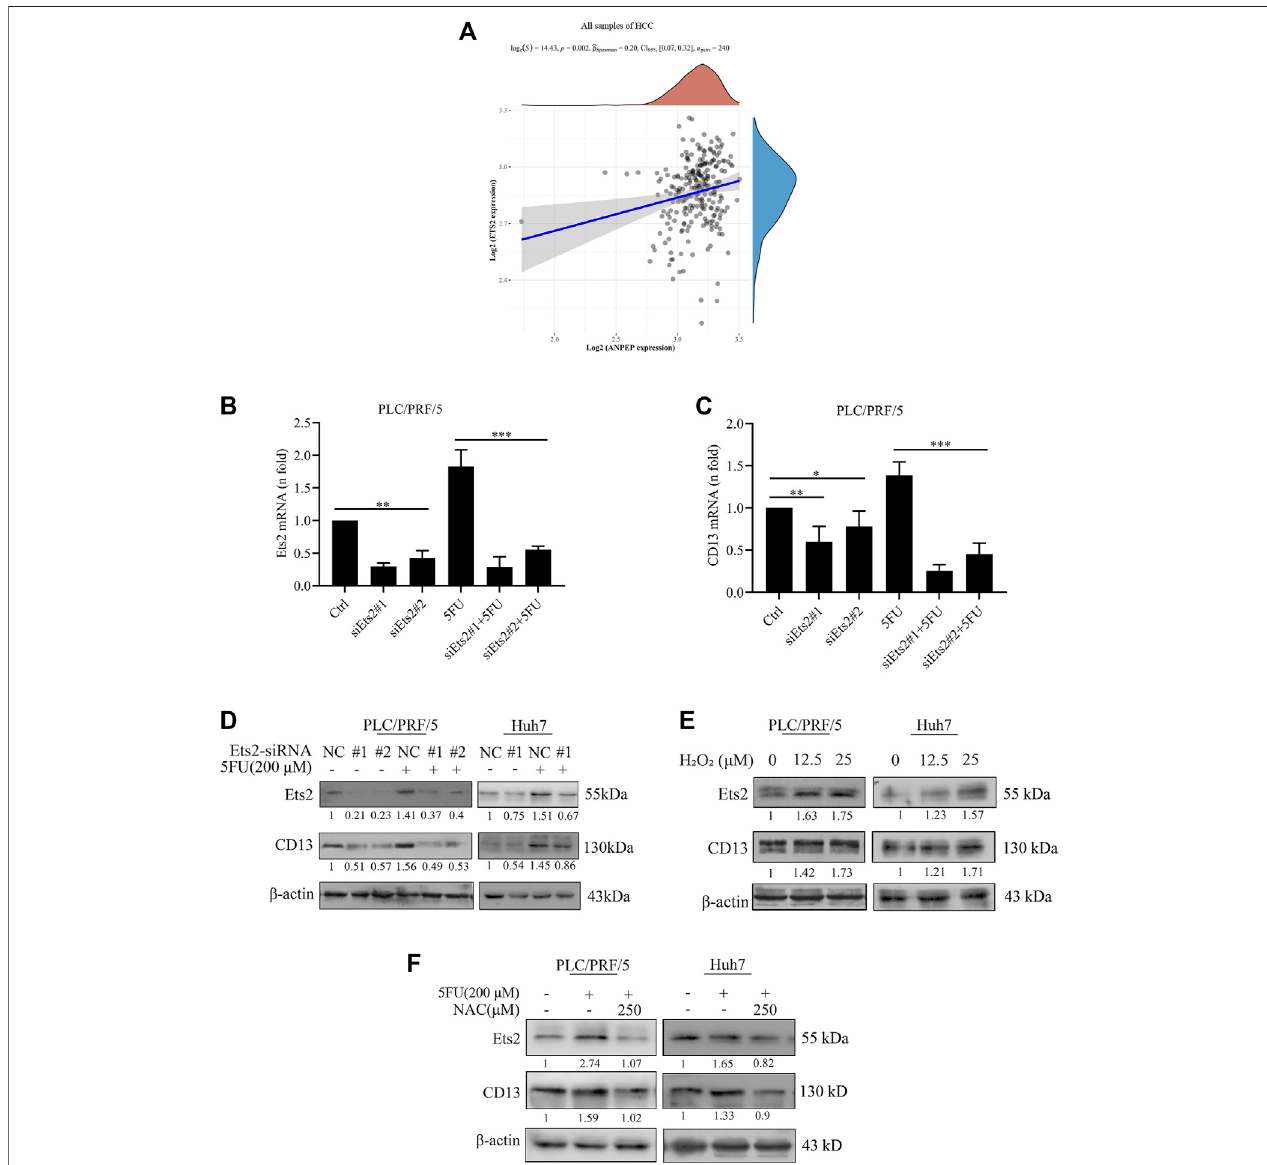
FIGURE2| ROSupregulates CD13expression through activating transcriptional factor Ets2. (A) The correlationbetween the expression ofCD13 and Ets2 in liver cancer samples (data from TCGA). ANPEP indicates CD13. (B,C) qRT-PCR analysis on PLC/PRF/5 cells transfected with Ets2-siRNA and treated with 5FU(200 μ M for 24 h). Data are presented as mean ± SEM ( n (cid:2) 3). * p ≤ 0.05, *** p ≤ 0.001. (D,E) Immunoblotting on Ets2 and CD13 protein expression PLC/PRF/5 and Huh7 cells. (D) Cells transfected with Ets2-siRNA and treated with 5FU for 48 h (E) cells treated with H 2 O 2 (12.5, 25 μ M) for 48 h. (F) Cells treated with combination of 5FU